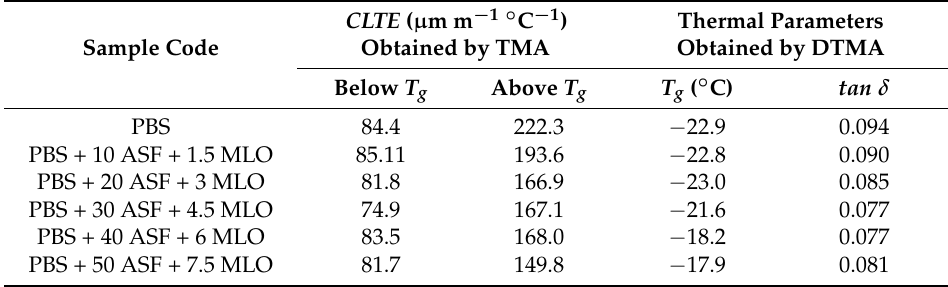
Table 5. Variation of the coefficient of linear thermal expansion ( CLTE ) below and above the glass transition temperature ( T g ) of PBS/ASF/MLO composites with varying ASF loading.